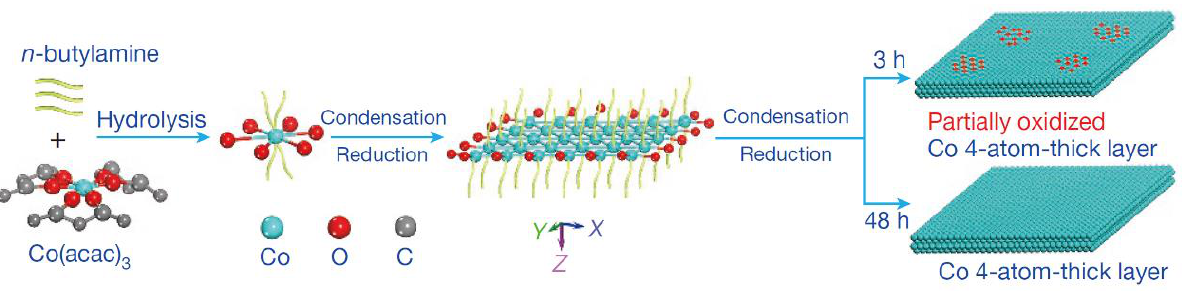
Figure 9. Size dependence of TOF for CO production on Pd NPs at various potentials. Reprinted from Ref. [113], copyright (2015), with permission from the American Chemical Society. As well known, the metal electrode possessed high activity for the catalytic reduction of CO 2 [114,115]. The outstanding catalytic activity was obtained by reducing metal oxides